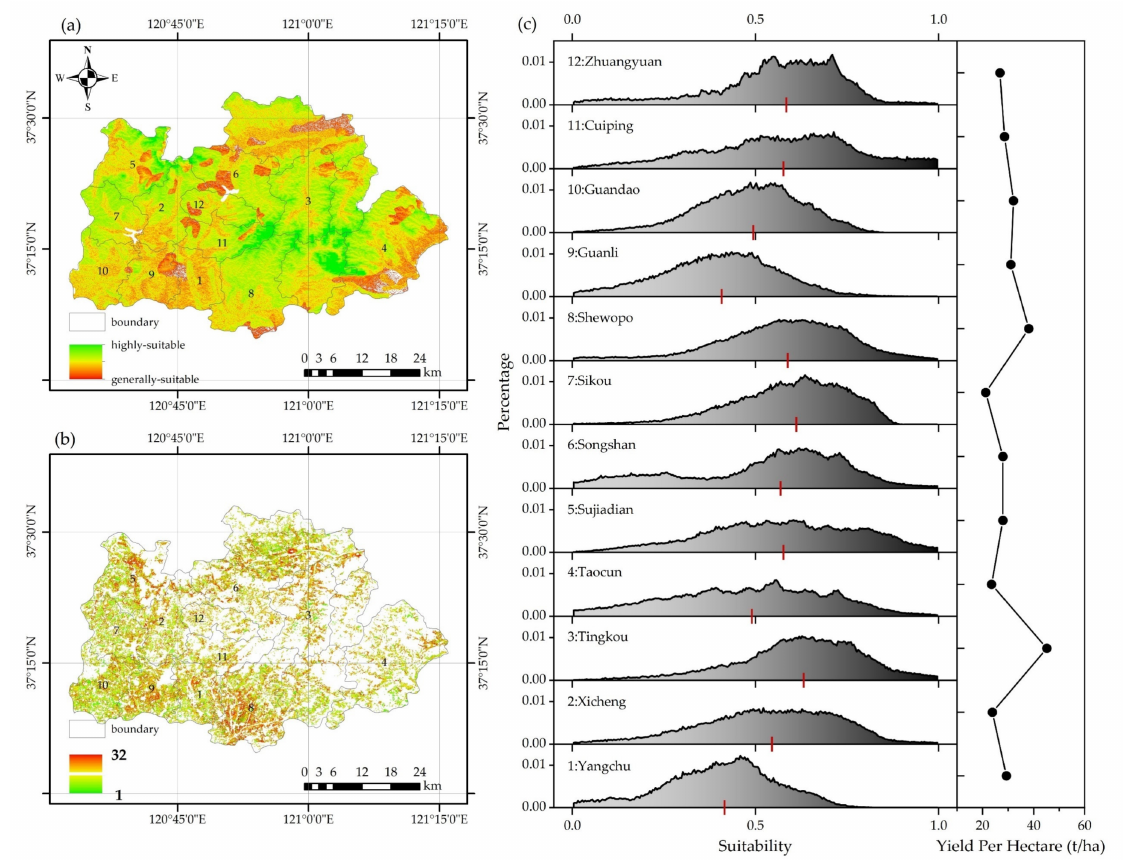
Figure 11. Relationship between orchard planting suitability and orchard yield. ( a ) The suitability of orchard planting. ( b ) The planting age of apple orchards. ( c ) Suitability distribution and yield of existing orchards in each county. The numbers in ( a ) and ( b ) correspond to ( c